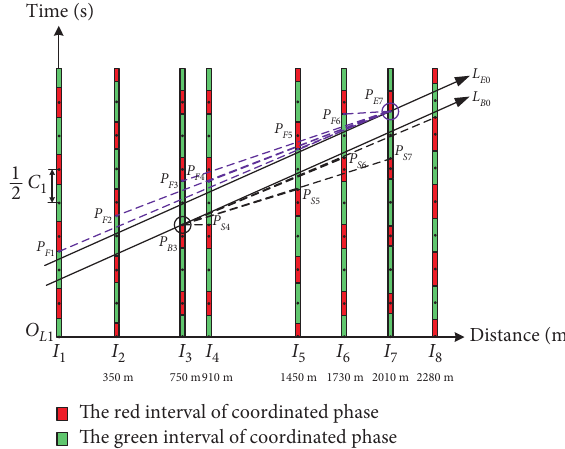
Figure 11: The coordination process of the first round of rotation transformation. (a) The 2nd rotation transformation. (b) The 3rd rotation transformation. (c) The 4th rotation transformation. (d) The 5th rotation transformation. (e) The 6th rotation transformation. (f) The 7th rotation transformation. (g) The 8th rotation transformation. (h) The obtained time-space diagram.